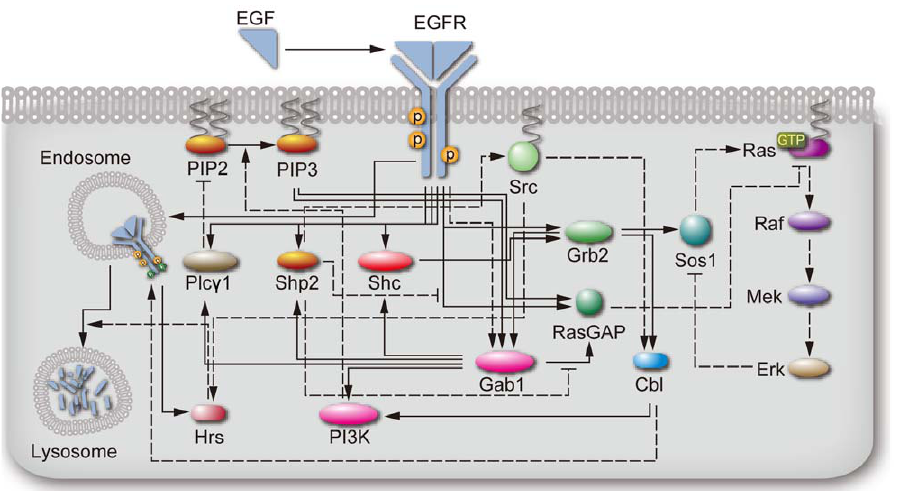
Figure 3. Schematic representation of HFPNe-based EGFR signal transduction model. Solid-line and dashed-line arrows denote direct physical interactions and indirect associations or catalytic reactions, respectively.